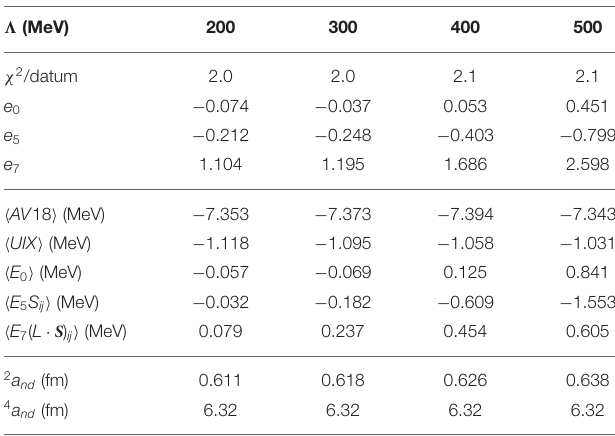
TABLE 4 | χ 2 /datum of the two-parameter fit to p − d elastic scattering data at E c . m . = 2 MeV, obtained neglecting in Equation (61) all the subleading operators except the leading contact term proportional to the LEC E 0 , and the tensor S ij and